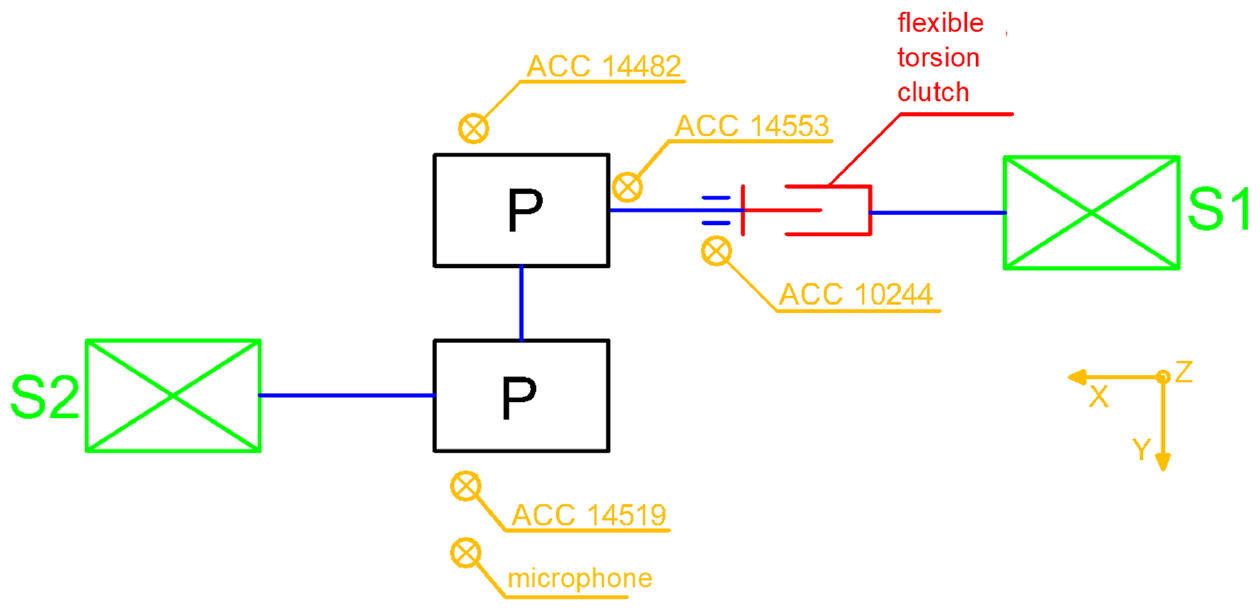
Figure 2. Kinematic diagram of the test stand and points of location of the measurement points.